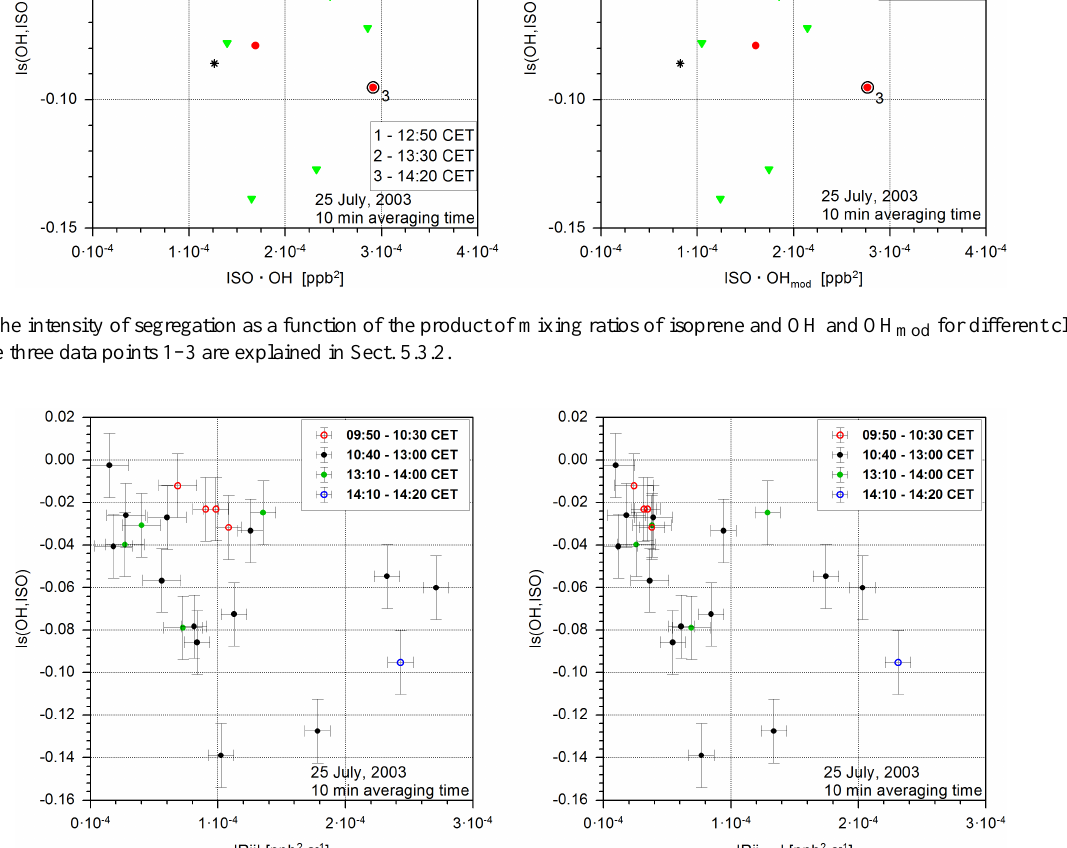
with data points indicated for different reaction conditions (see text). mod